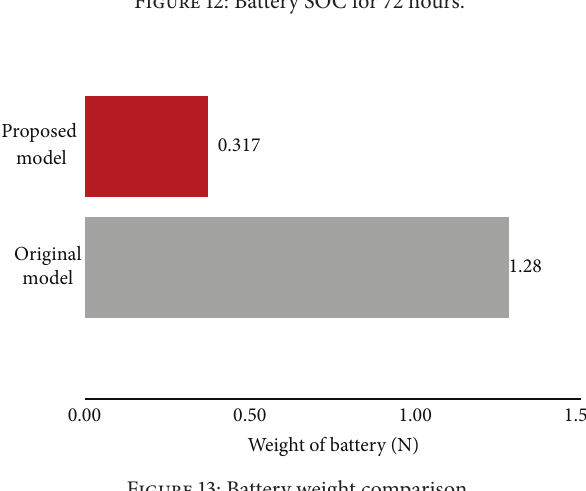
Figure 13: Battery weight